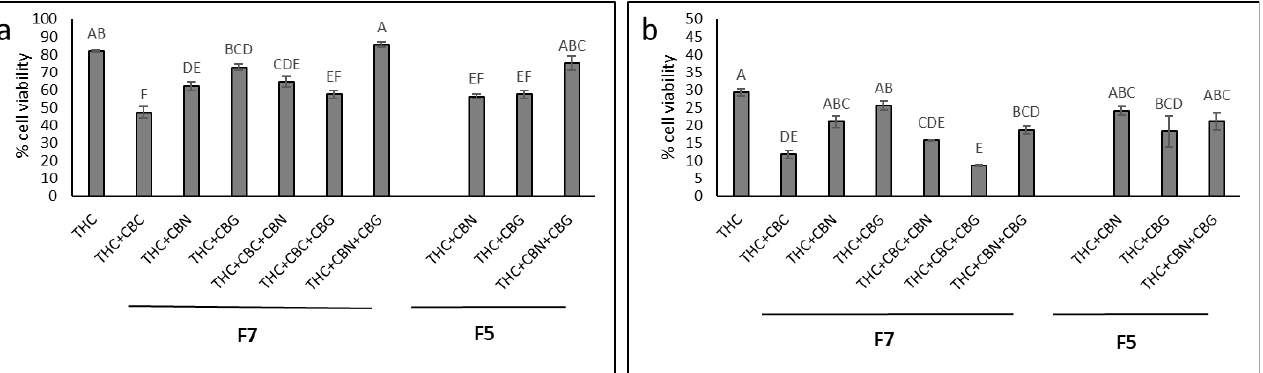
Figure 4. Cell viability of HTB75 cells following treatment with THC or with combinations of THC, CBG, CBC and CBN as in F7 or F5, at total concentrations of ( a ) 13 and ( b ) 15 µg/mL (treatments are listed in Supplementary Table S3). Cell viability was determined by XTT assay as a function of live cell number at 48 h. All calculations were in relation to the control (the vehicle treated control of 1.30% and 1.50% v/v methanol for a and b, respectively) that was considered to have 100% cell viability (not shown). Error bars indicate ± SE ( n = 3). Levels with different Upper case letters were significantly different from all combinations of pairs by Tukey–Kramer honest significant difference (HSD; p ≤ 0.05).